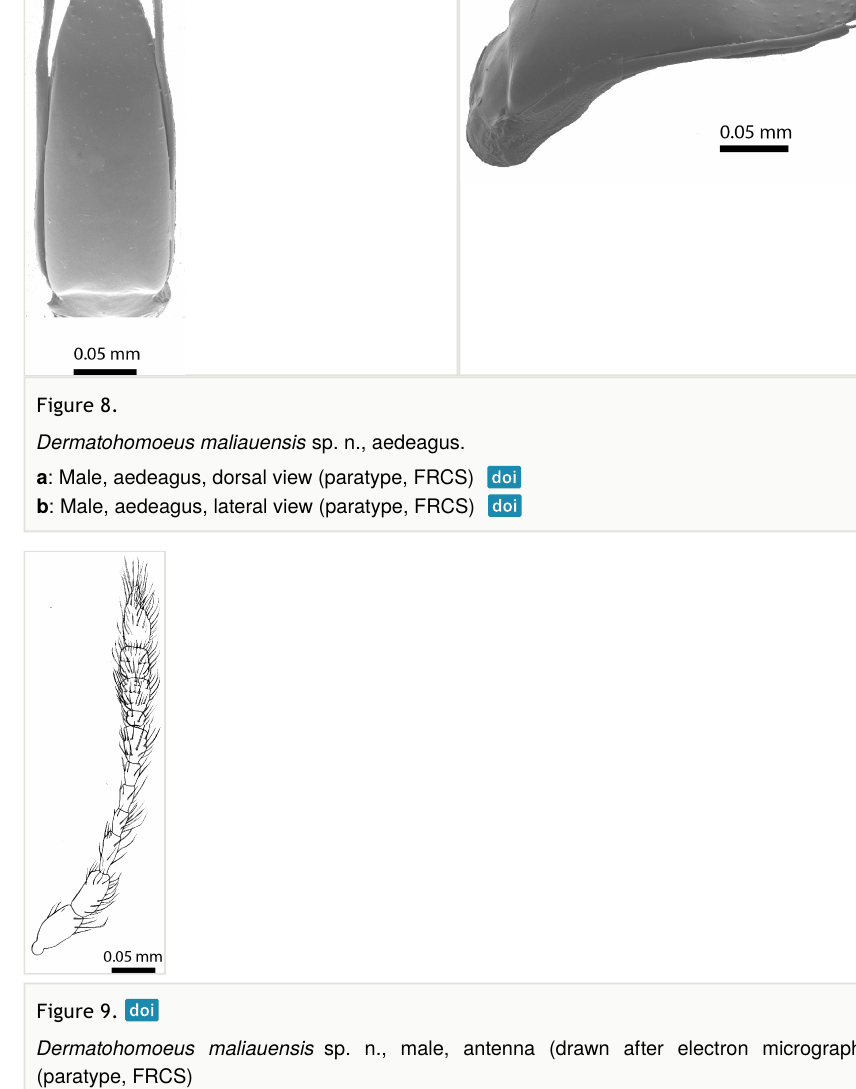
Figure 9. Dermatohomoeus maliauensis sp. n., male, antenna (drawn after electron micrograph) (paratype,